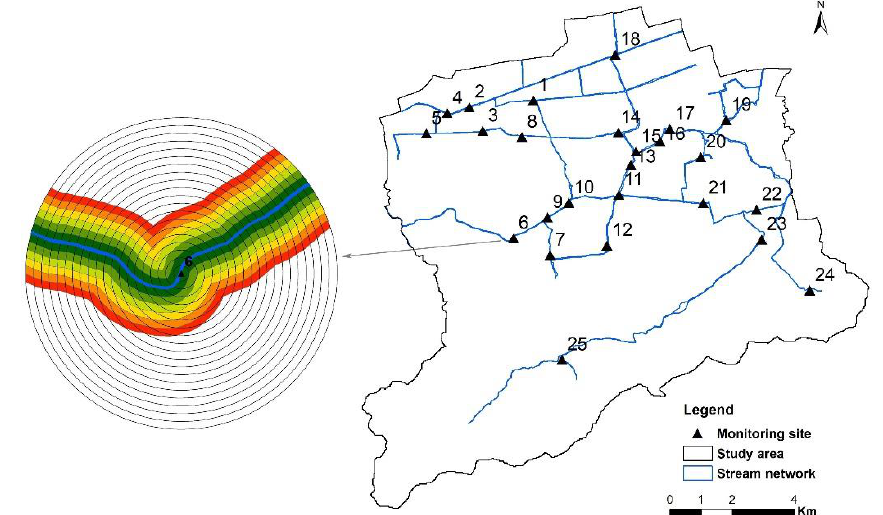
Figure 3. Spatial distribution of surface water quality monitoring sites. The left subfigure shows the buffering schema, i.e., the circular buffer and riparian buffer, used in this study. The interval of the neighboring buffers is 50 m. The circular buffer is a series of buffers around the sampling point with radiuses ranging from 50 to 1000 m, and the riparian buffer is along the particular stream bank with distances ranging from 50 to 300 m.